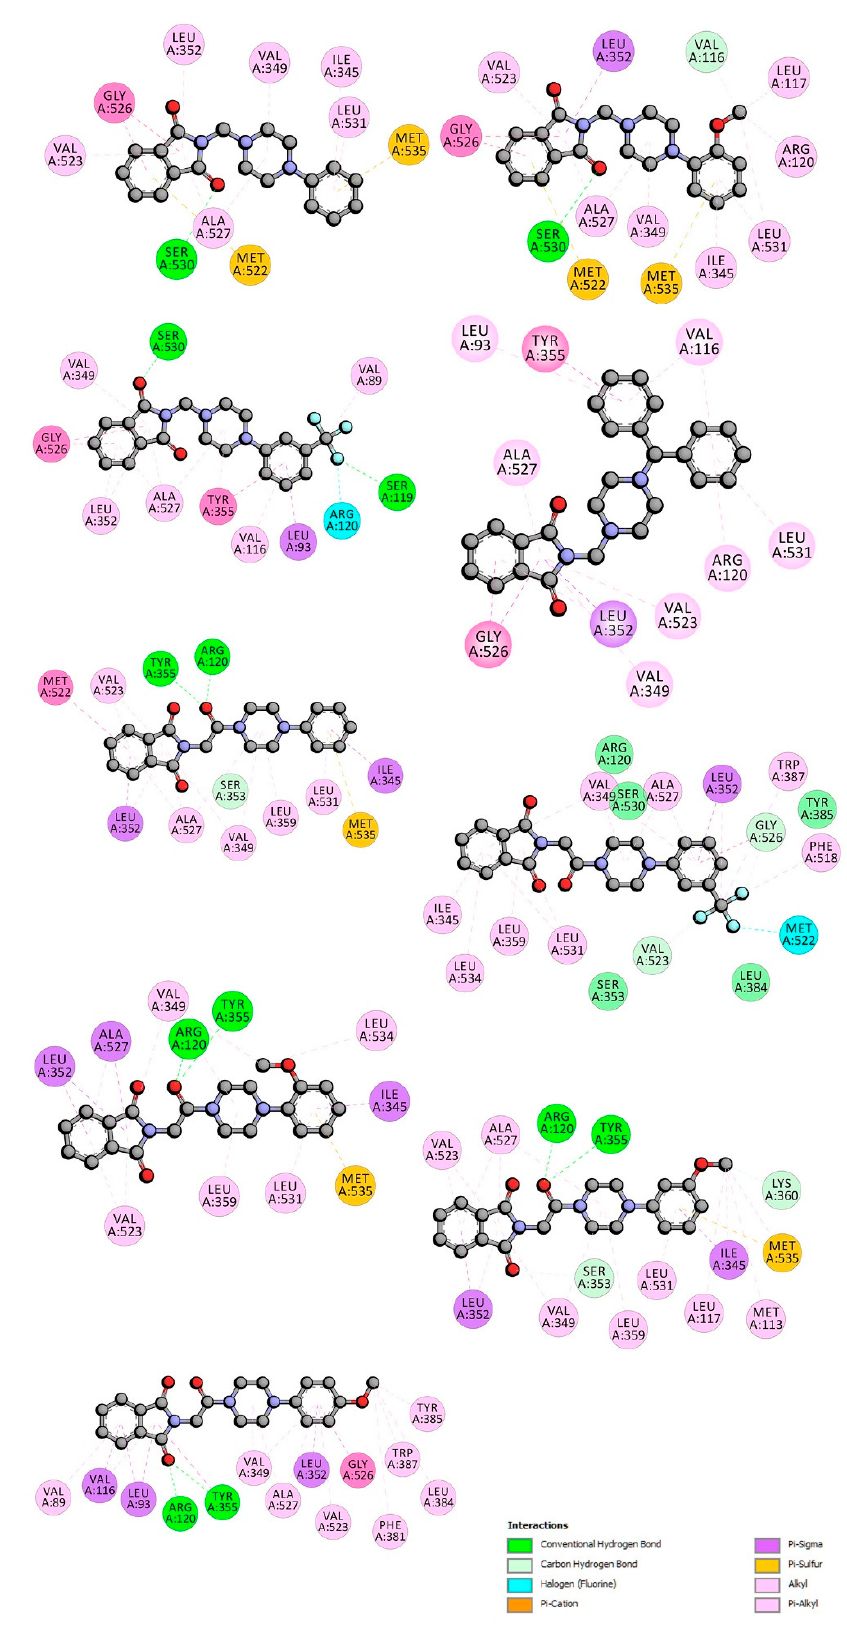
Figure 2. 2D interaction plot of studied compounds with COX-2.